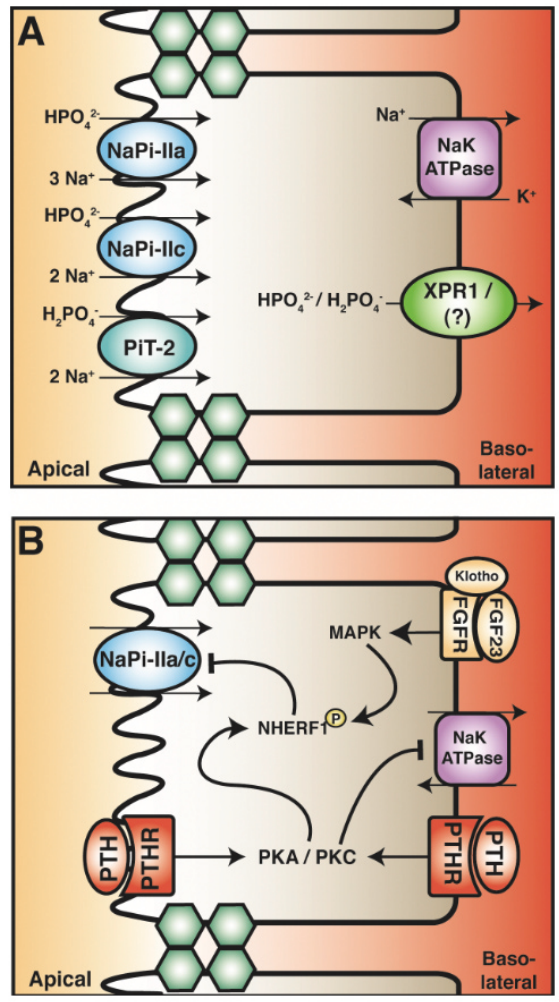
Figure 3. Proximal tubule (PT) phosphate reabsorption. ( A ) Phosphate reabsorption in the PT is mediated by the transcellular pathway. Apical entry occurs through the sodium-phosphate exchanger family (NaPi) subtypes IIa and IIc and